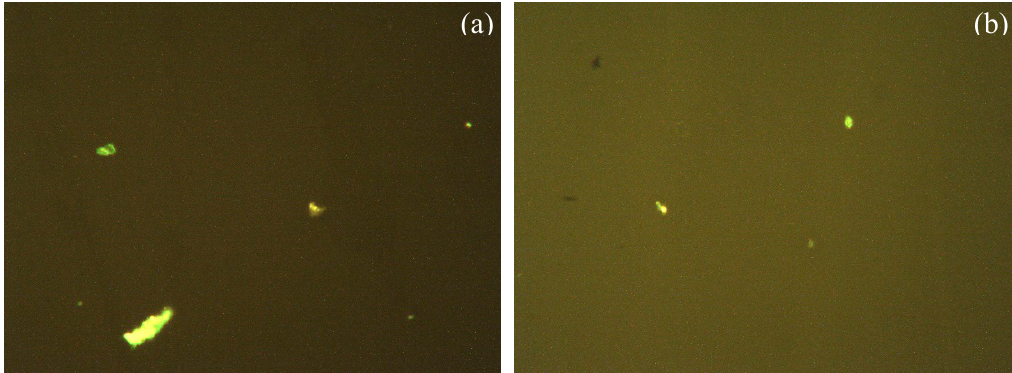
Figure 13. Fluorescence microscope (FM) pictures of bitumen from BD-UL and BD-BL (100 × ): ( a ) BD-UL and ( b )